Question: Name the type of graph shown.
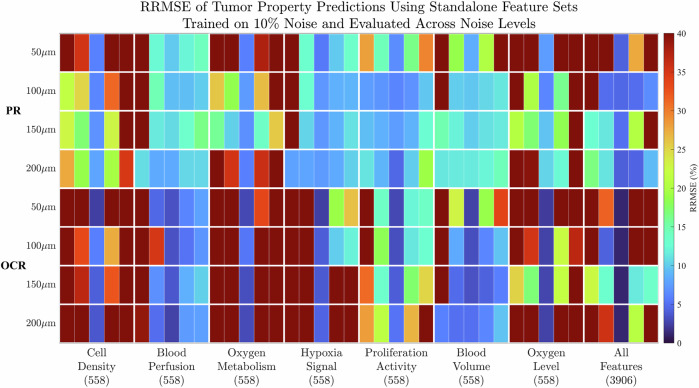
Answer: heatmap